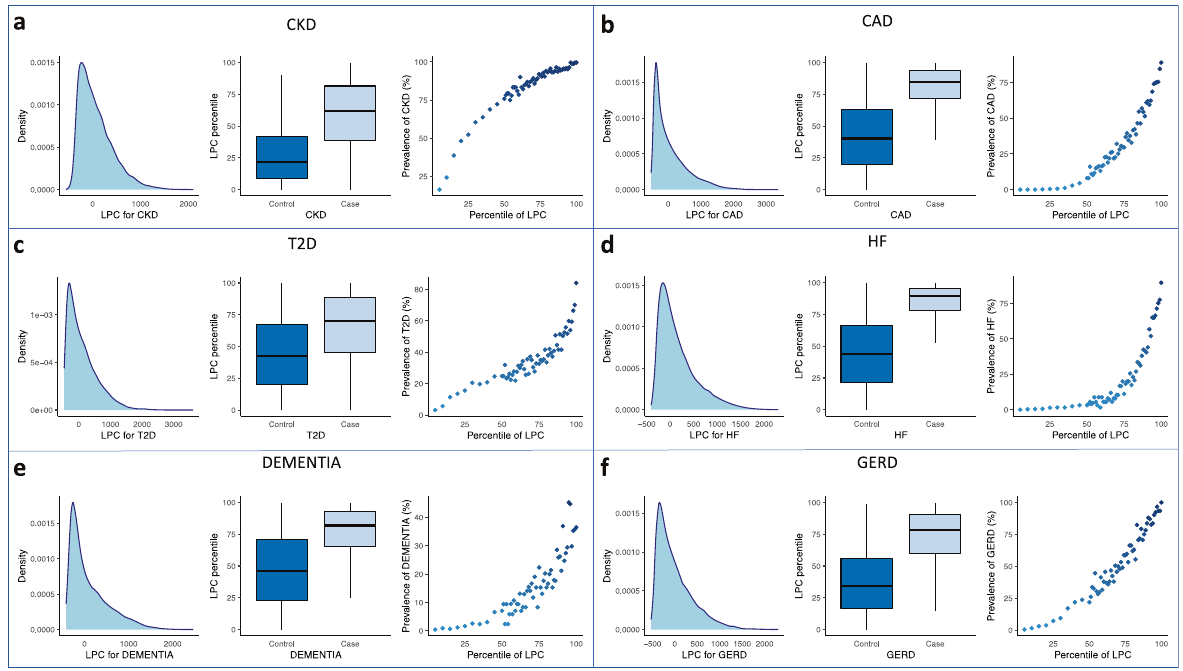
Fig. 3 Distribution of fi nal LPC scores for six phenotypes in the test set. LPC risk scores are derived based on all phecodes. Estimated density and distribution of LPC risk scores cases vs. controls for a CKD (cases including G1, G2, G3a/b, and G4 stages), b CAD, c T2D, d HF, e Dementia, and f GERD. For each phenotype: left, distribution of LPC risk scores in the test set. Middle, LPC risk score percentiles among cases vs. controls. Right, case prevalence in 60 bins according to the percentiles of LPC risk scores. The center line, lower and upper bounds of the box represent the median, fi rst quartile ( Q 1 , or 25th percentile), and third quartile ( Q 3 , or 75th percentile) of the data, respectively. The whisker is drawn up (down) to the largest (smallest) observed point from the data that falls within 1.5 times the interquartile range ( = Q 3 − Q 1 ) above (below) the Q 3 ( Q 1